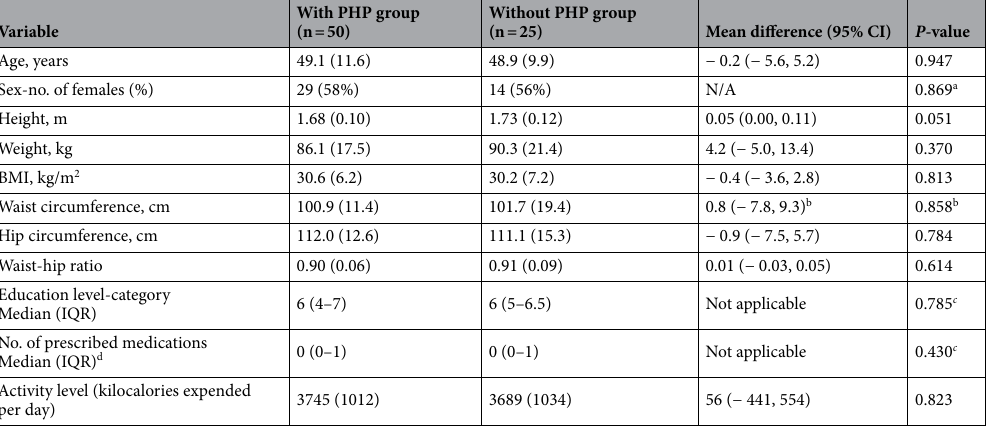
Table 1. Comparison of participant characteristics between the PHP and control groups—values are means (SDs) unless otherwise stated. a P -value relates to Chi-squared test. b Mean difference, 95% CIs and p -value adjusted as Levene’s test for Equality of Variances was significant ( P < 0.05). c P -value relates to Mann–Whitney U test. d Variable not normally distributed. IQR Interquartile range.